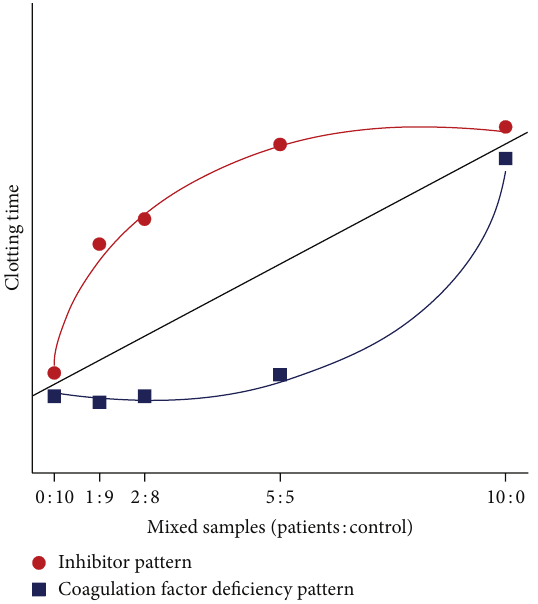
Figure 3: Cross-mixing test for detection of lupus anticoagulants or inhibitor of coagulation factor. A convex upward curve indicates the presence of inhibitors, including lupus anticoagulants and coagula- tion factor-neutralizing antibodies, while a convex downward curve indicates the presence of a factor